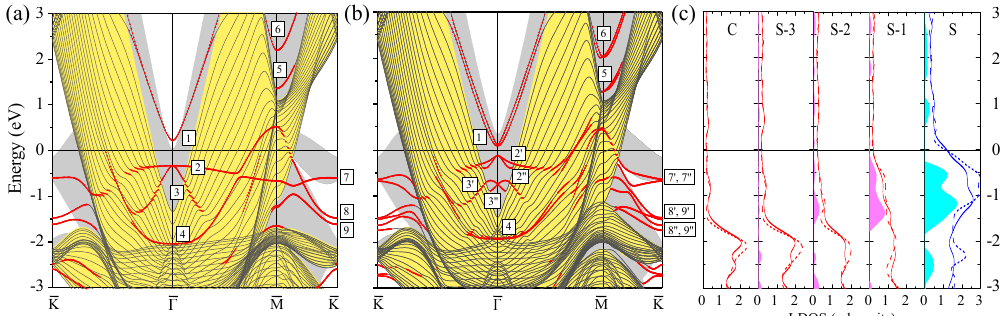
Figure 6. The electronic structure of the 1 ML-Pt/Au(111) surface calculated without ( a ) and with ( b ) spin–orbit interaction. The surface and quantum-well states and resonances are indicated by red dots. The states discussed in the text are labeled by symbols. In ( c ), the layer density of states is shown for the Pt, top three and central Au atomic layers. Blue and pink regions show the excess of LDOS in, respectively, Pt and Au layers in comparison with the corresponding bulk values.